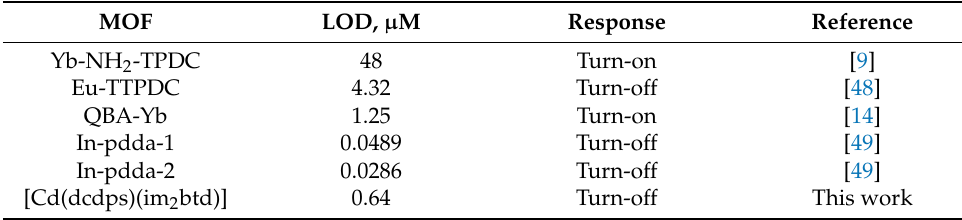
Figure 7. Fluorometric titration of gossypol: ( a ) Emission spectra of MOF 1 ethanol suspension at 310 nm excitation, with different amounts of gossypol added and the cottonseed oil as background; ( b ) Linear approximation of luminescence quenching for LOD calculation. The relative lumines- cence quenching values were calculated from the integral intensities.